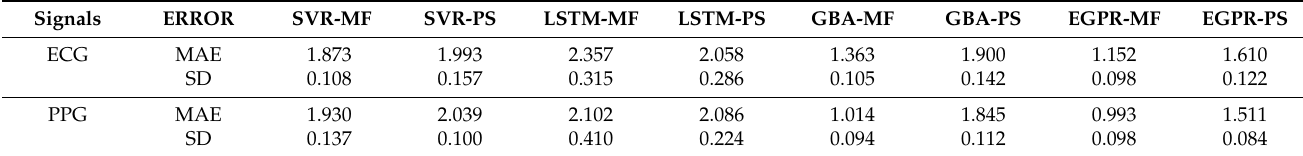
Table 3. The RR estimation results obtained using the ECG and PPG-based all hybrid models are computed as the difference from the reference RR values to express it as the MAE and SD